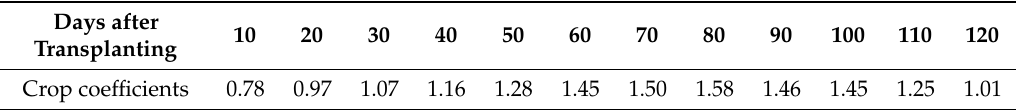
Crop coefficients for calculating AET (actual crop evapotranspiration) based on Penman-Monteith equation [17].